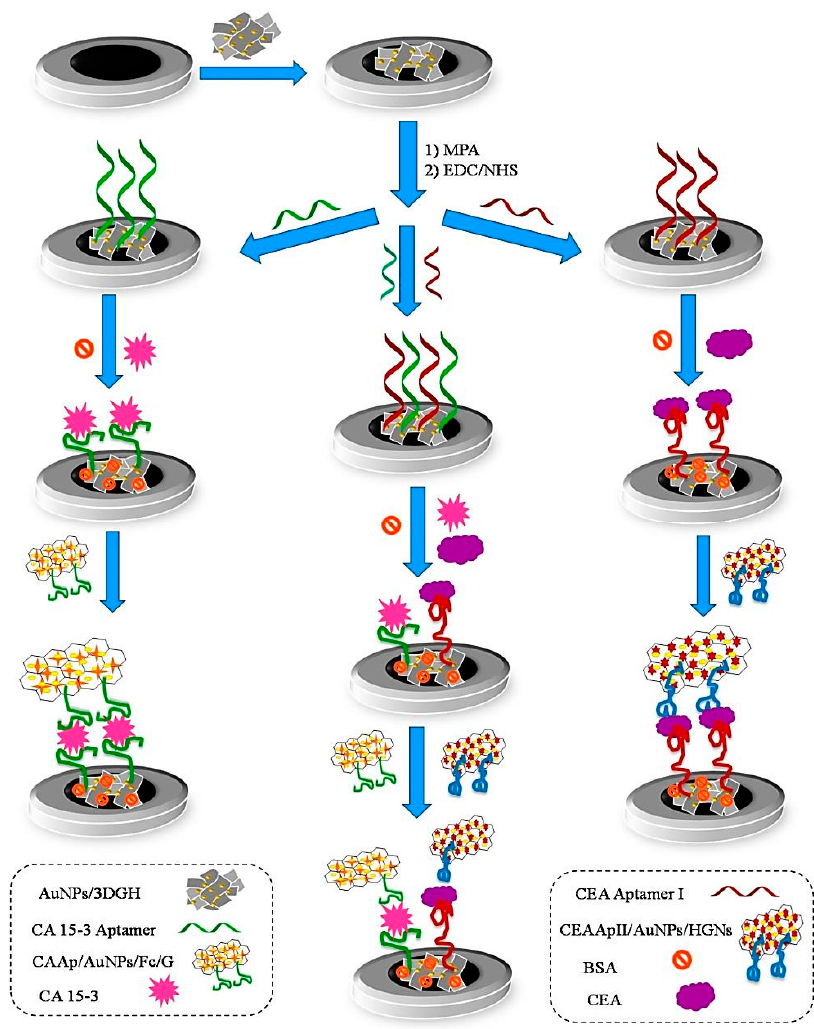
Figure 2. Schematic illustration of the sandwich-type aptasensor for the individual and simultaneous detection of CEA and CA 15-3 breast cancer biomarkers. Reprinted from [25] with permission. Prostate cancer is the most common cancer among men and the second-leading cause of cancer death in men. At the moment, the gold standard option for diagnosing prostate cancer is the measurement of prostate-specific antigen (PSA) in serum (as a prostate cancer biomarker), which is severely questioned due to the increasing number of unnecessary interventions in stunted or slow-growing tumors that increase patients’ general health and anxiety [26]. One the most popular methods for the diagnosis of prostate cancer is testing PSA levels in blood serum. However, this test show several disadvantages such as limited sensitivity of ~80%, low specificity of ~20% within “normal” ranges, and high false-positive rates, which leads to unnecessary biopsies and patient overtreatment [27]. Moreover, PSA can also be detected in other noncancerous prostate disorders such as be- nign prostatic hyperplasia (BPH), prostatitis, and trauma. Therefore, finding new bi- omarkers with the ability to accurately diagnosis early-stage prostate cancer is very desir- able. Yan et al. (2022), used sarcosine as a promising biomarker in association with PSA to diagnose prostate cancer [27]. They developed an electrochemical aptasensor for the combined measurement of dual biomarkers that facilitated the robust detection of differ- ent states of prostate cancer, especially for early diagnosis. For the fabrication of this ap- tasensor, hierarchical MoS 2 nanoflowers and spherical SiO 2 nanoprobes were used as a functional interface and for signal amplification, respectively (Figure 3). Initially, the sur- face of the GCE was modified with MoS 2 nanoflowers and applied as a functional